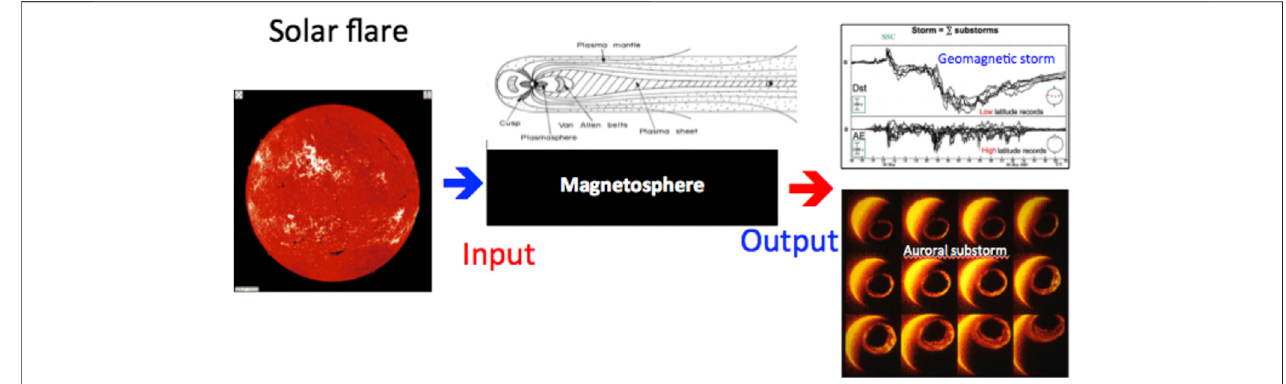
FIGURE1| Aschematicpresentation,indicatingtheroleofthemagnetosphere,receivingsolarwinddisturbancesastheinputandproducinggeomagneticstorms and auroral substorms as the output.